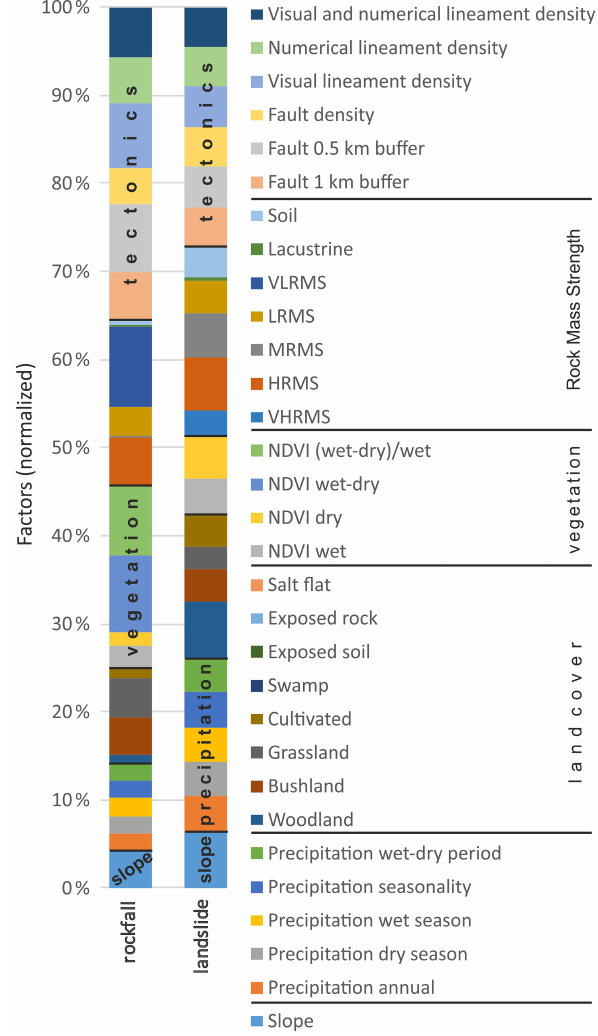
Figure 8. Plot of mean values of particular factors occurring across landslides and rockfalls polygons normalized to the mean value for the whole area. Diagram shows the relative importance of each fac-